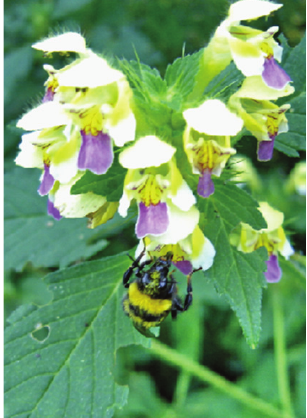
Figure 4: Newly emerged young queen of B. pratorum feeding on Cirsium oleraceum.